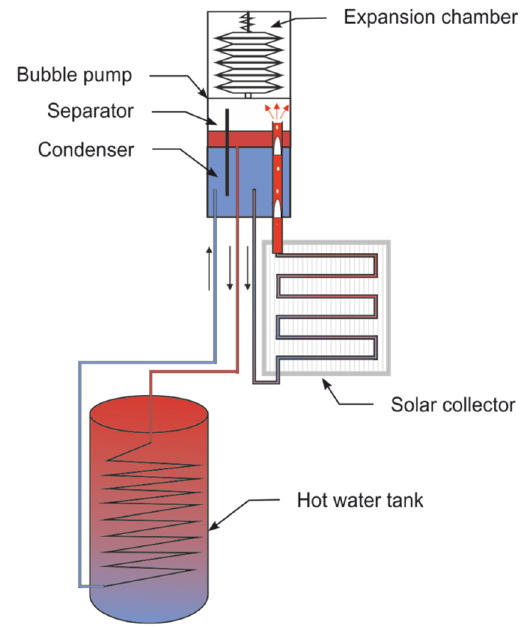
Figure 4. Diagram of a heat exchanger with a vapor lift pump (The figure is based [31]).